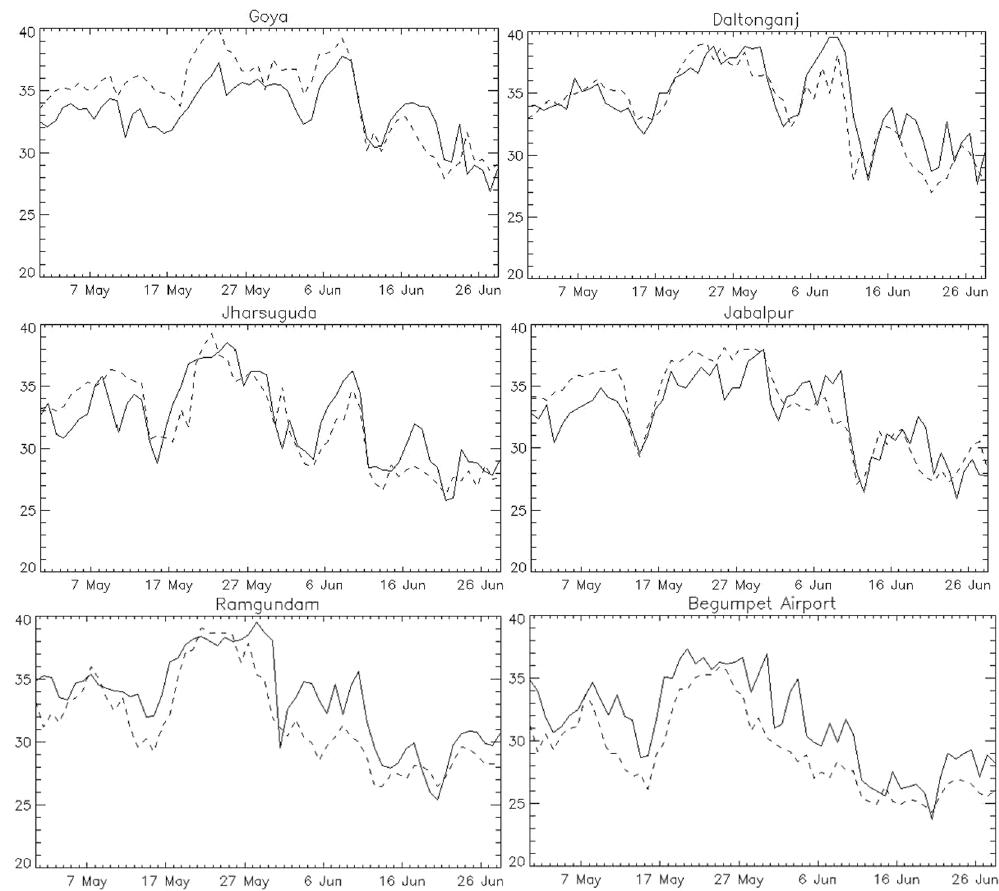
Figure 2. Daily SAT (°C) during May and June in 2015 for station observations (solid line) and MLD output (dashed line). Data visualizations produced using IDL [8.4] (Exelis Visual Information Solutions, Boulder,